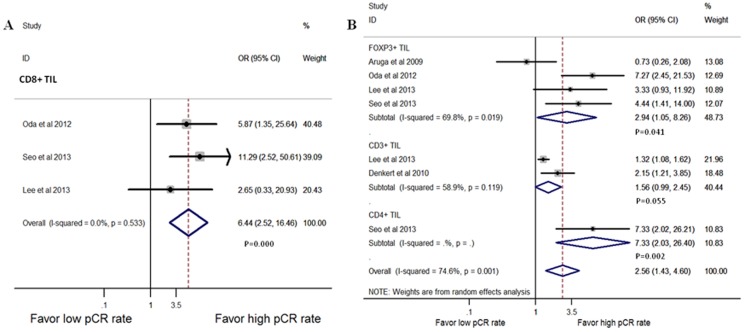
Forest plots from the fixed- or random-effect meta-analysis of the efficacy of TILs subset on NAC response in pre-treatment biopsy (A, B).The width of horizontal line represents 95% CI of the individual studies, and the grey boxes represent the weight of each study. The diamond represents the overall summary estimate. The unbroken vertical line was set at the null value (HR = 1.0).